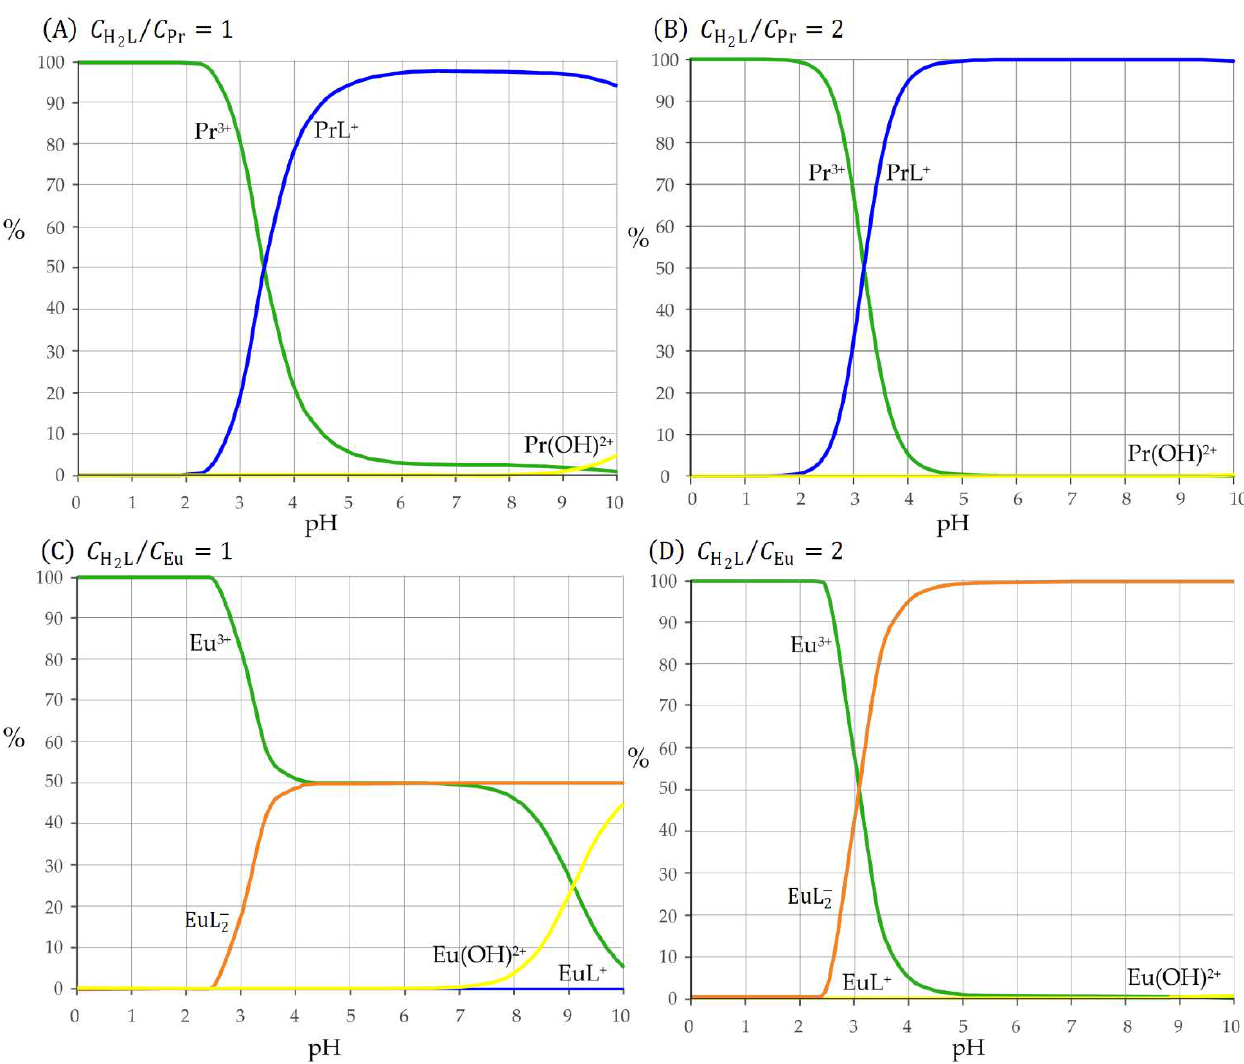
Figure 6. Distribution diagrams for: Pr 3+ –harzianic acid and Eu 3+ –harzianic acid systems: ( A ) and ( C ) equal total concentrations (10 −4 M) of harzianic acid and metal cations; ( B ) and ( D ) harzianic acid total concentration (2 × 10 −4 M) twice the total concentration of metal cations.